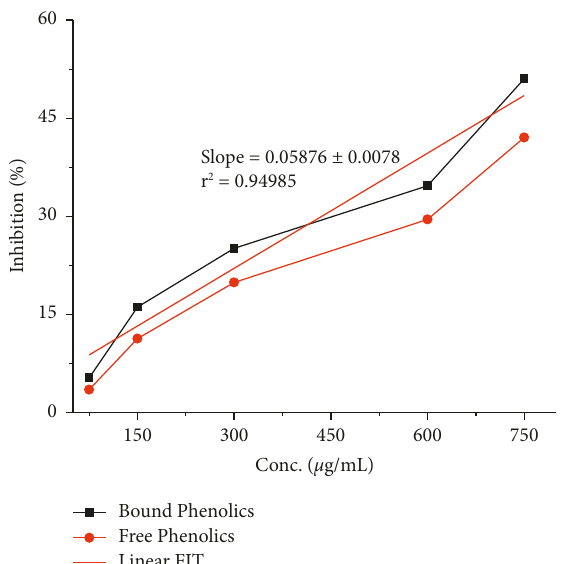
Figure 6: α -Glucosidase median inhibitory potential of Schoeno- plectus triqueter phenolics.